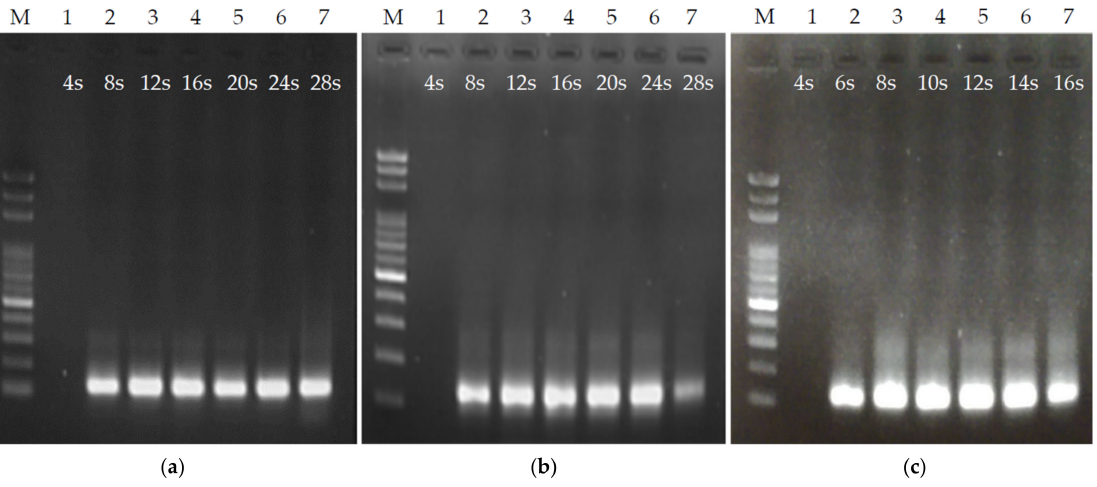
Figure 5. Ultrafast PCR tests under different channel lengths and flow rates. ( a , b ) PCR results with a 56 µ m channel height and a channel length of 6 and 4 cm/cycle, with each thermal cycle lasting 4–28 s. ( c ) PCR results with a 56 µ m channel height and a channel length of 2.4 cm/cycle, with each thermal cycle lasting 4–16